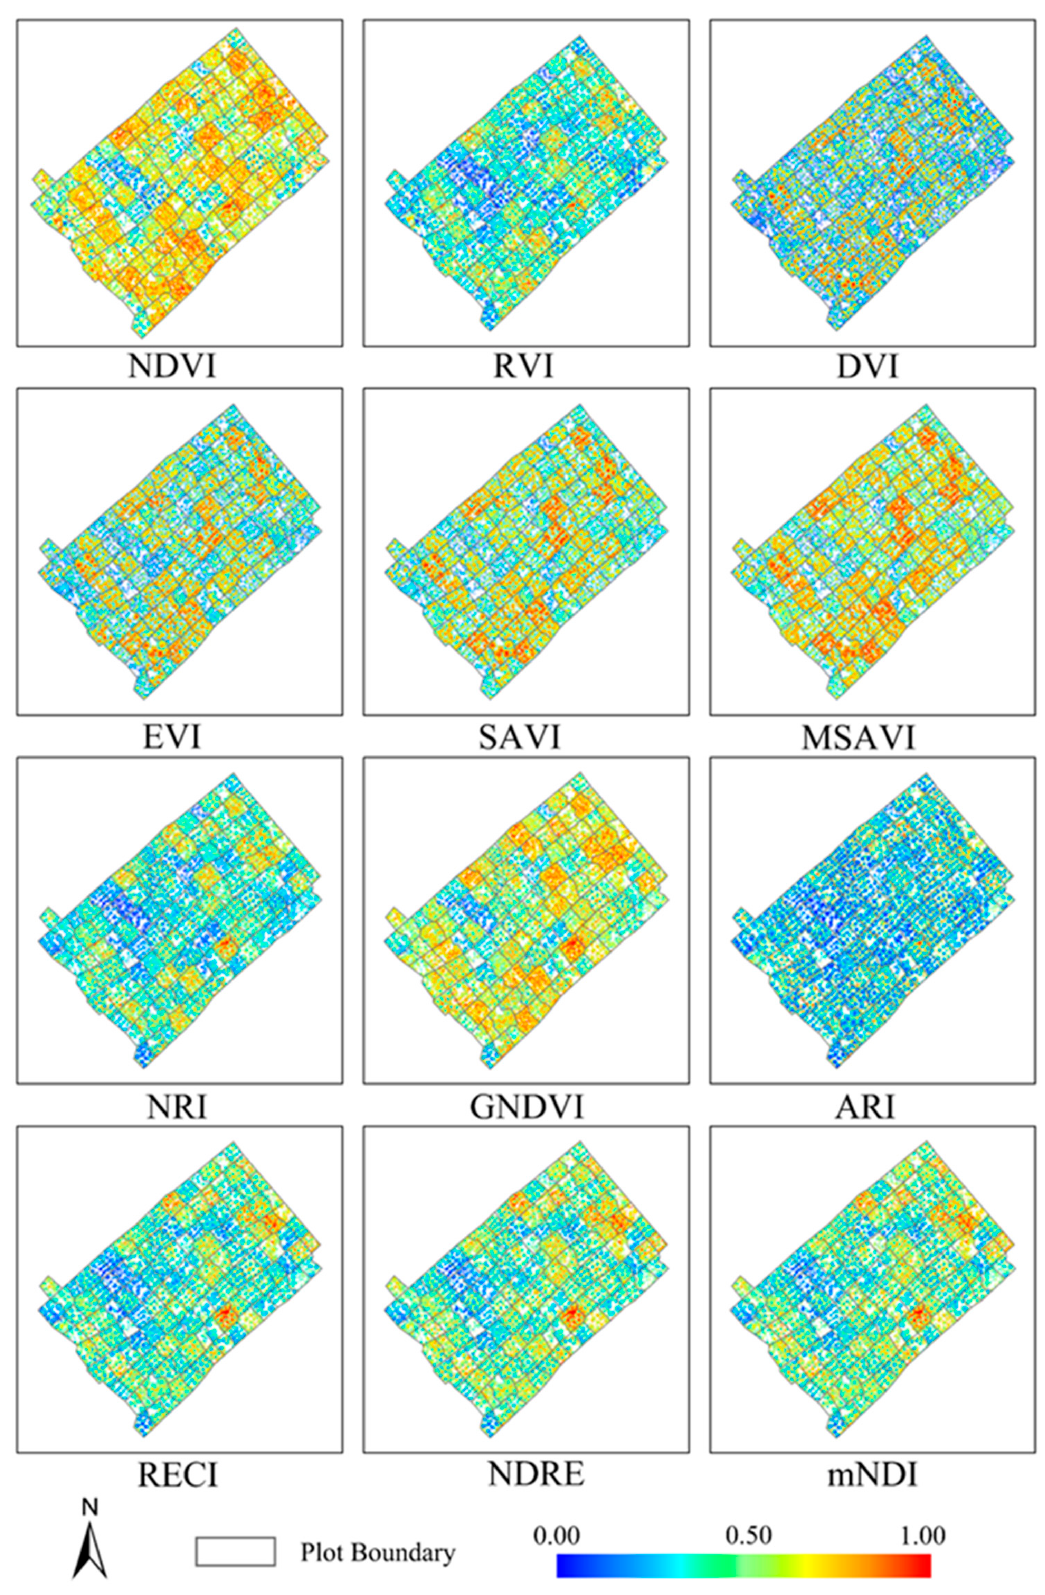
Figure 7. Twelve vegetation index (VI) maps in the eucalypt clonal trial site. For a better visualization, each vegetation index was normalized. The area shown is the vegetation area extracted by a DVI automatic threshold segmentation, and the gray lines are used to indicate the clonal plot boundaries.